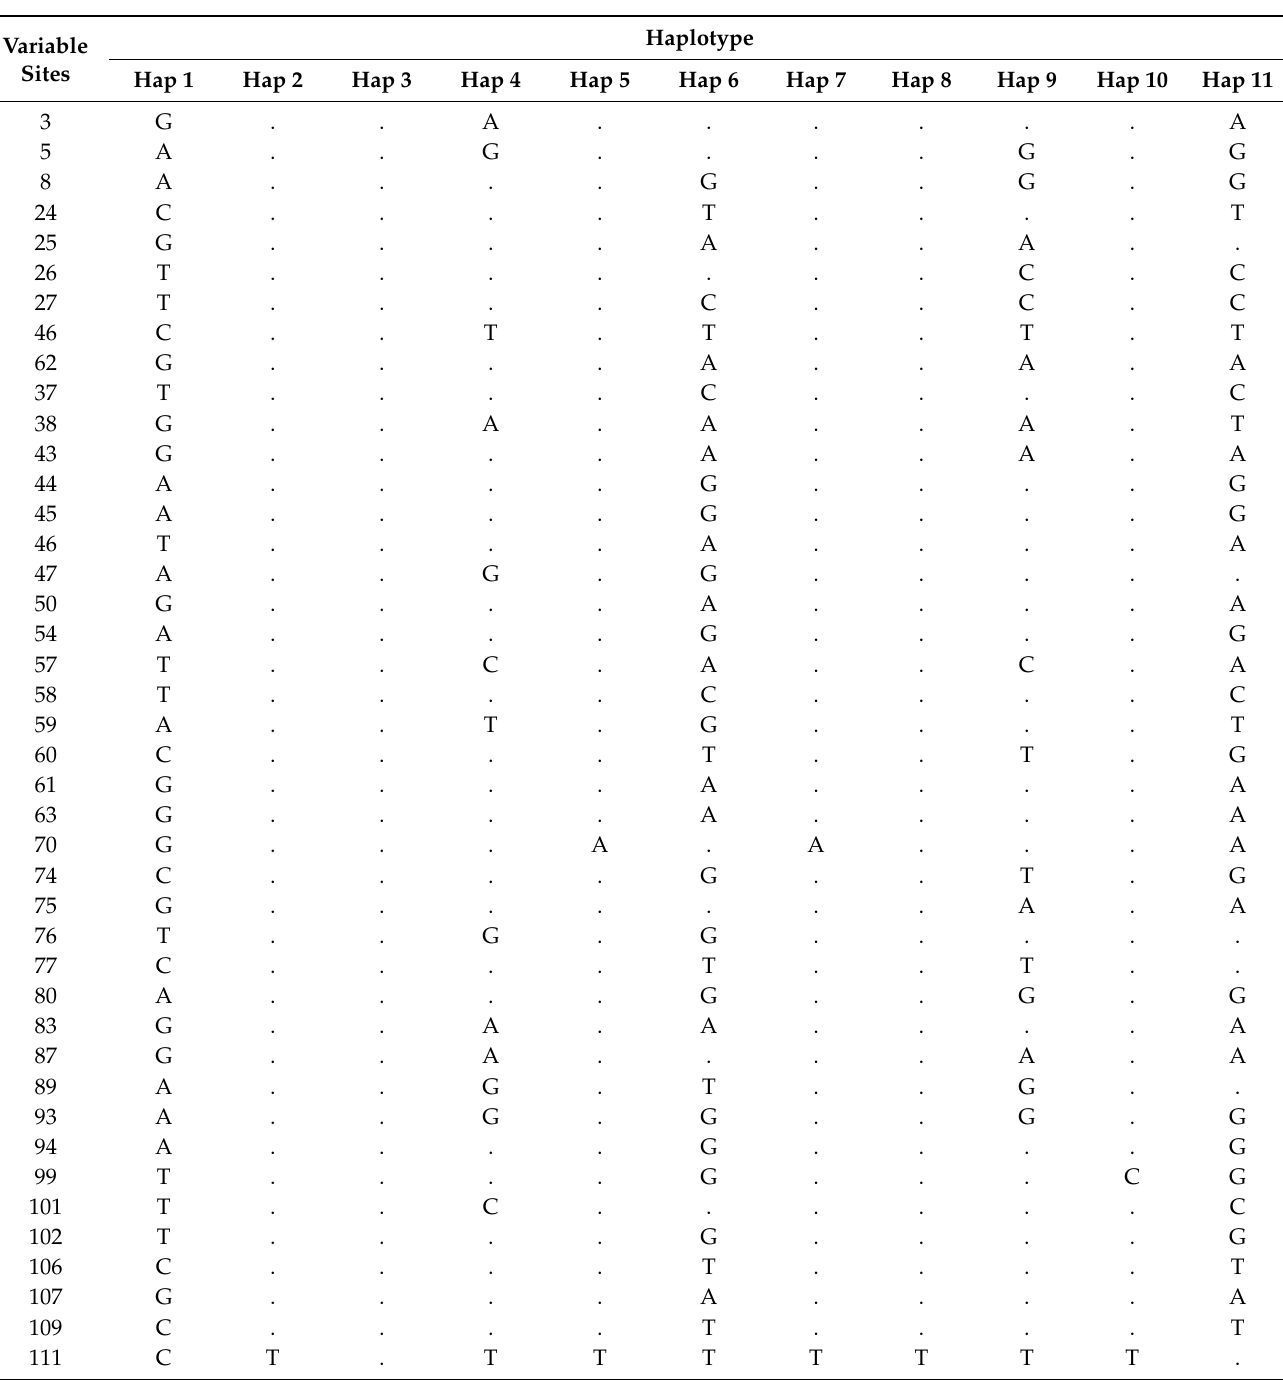
Table A1. Variable sites of mitochondrial DNA COI gene haplotypes in C. alburnus